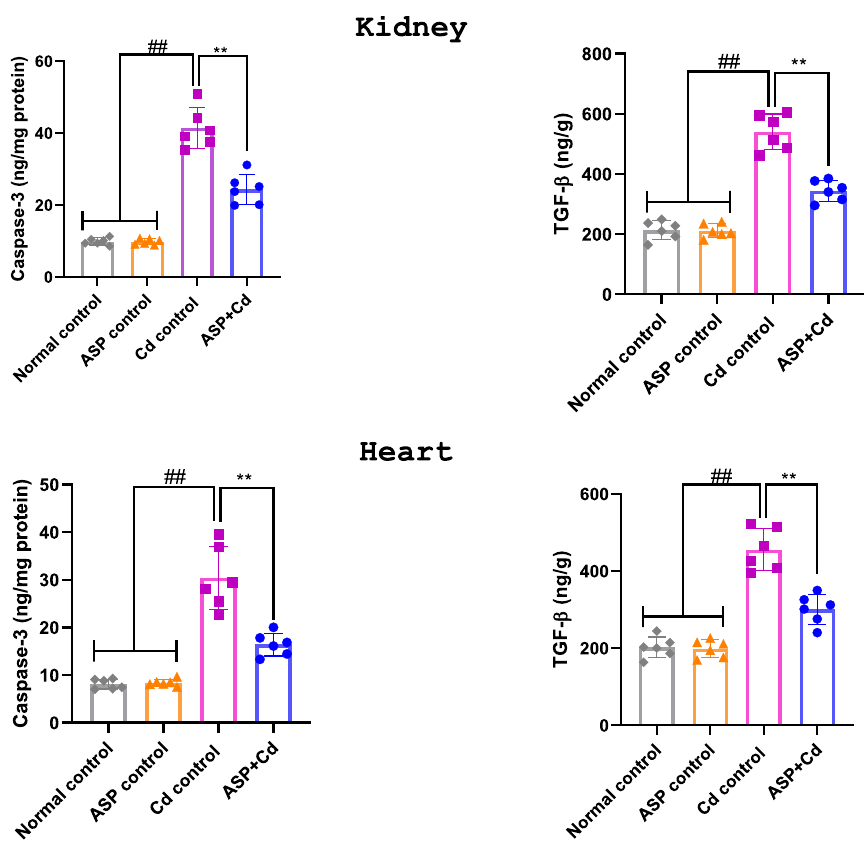
Figure 4. Effects of asperuloside on kidney and heart caspase 3 and TGF-β of cadmium administered rats. Histograms represent the mean ± SD (n = 6). For all panels: ## p < 0.05 compared to normal and ASP control groups; ** p < 0.05 compared to Cd control group